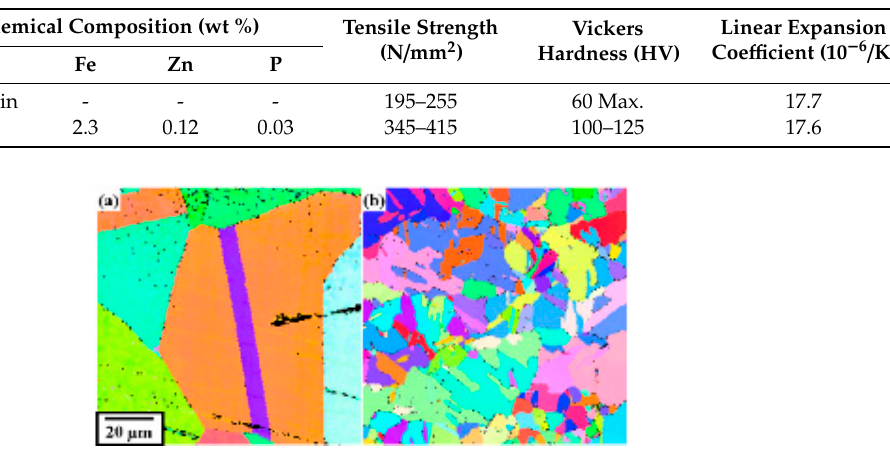
Table 1. Chemical composition and physical property values of the copper alloys used in this study.